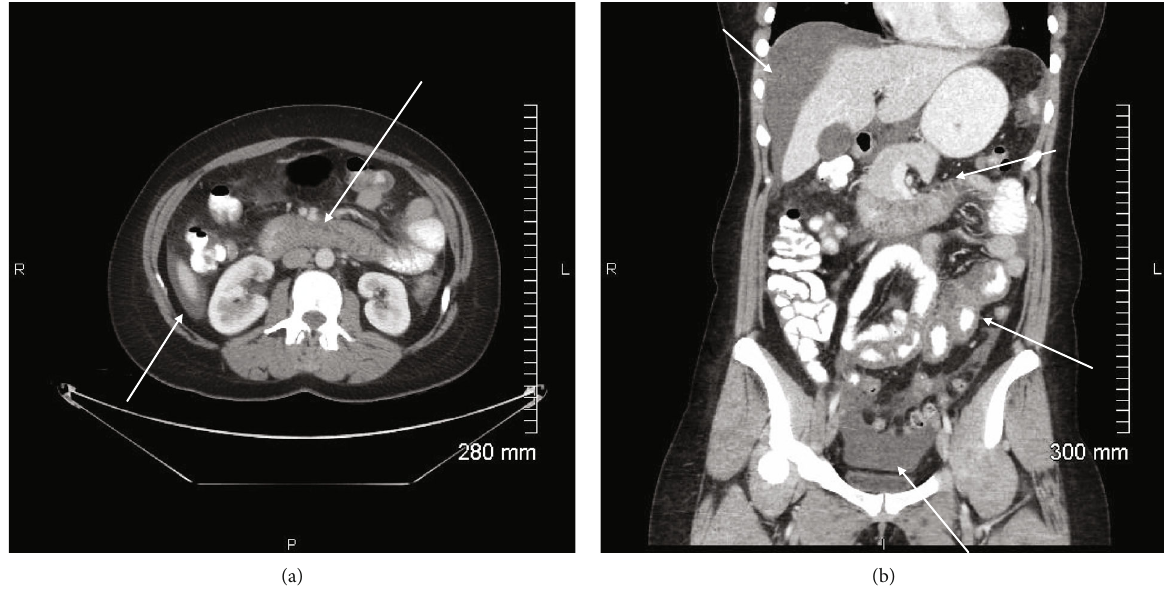
Figure 1: Axial (a) and coronal (b) contrast-enhanced CT scan of the abdomen and pelvis. Images demonstrate a moderate amount of abdominopelvic ascites with di ff use wall thickening, hyperenhancement, and mucosal edema of the entire small